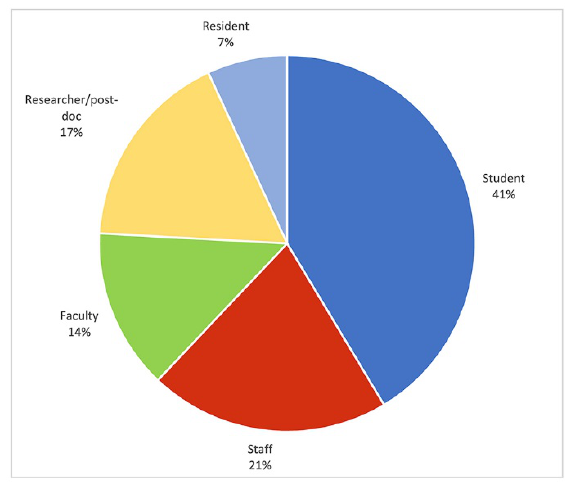
Figure 1 Who uses the wellness and self-care space